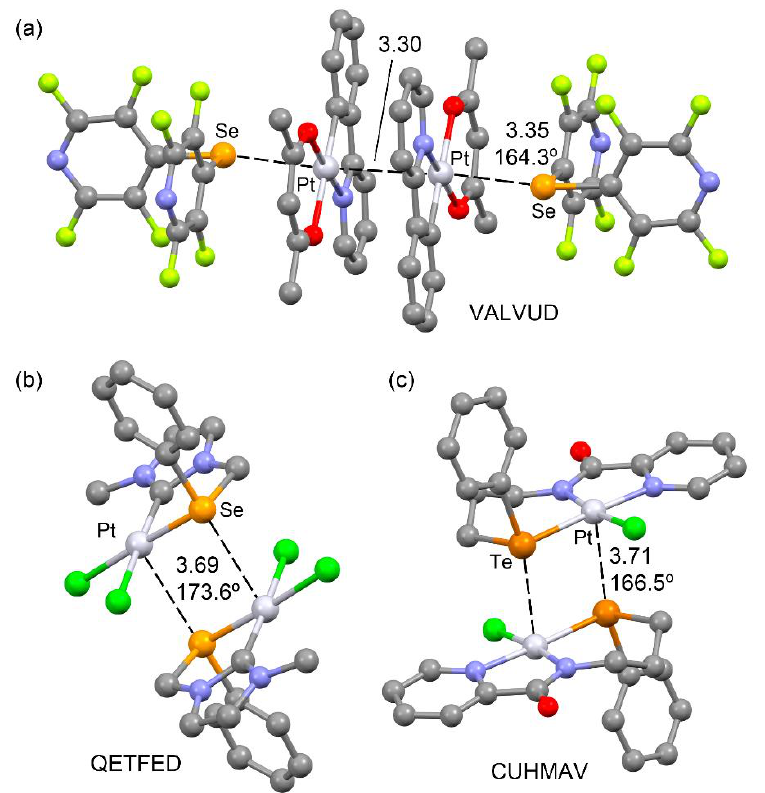
Figure 2. X-ray structures of VALVUD ( a ), QETFED ( b ) and CUHMAV ( c ). H-atoms omitted. Distances are given in Å. Color code: Carbon grey, chlorine green, platinum light grey, selenium orange, tellurium tangerine, oxygen red, nitrogen blue.